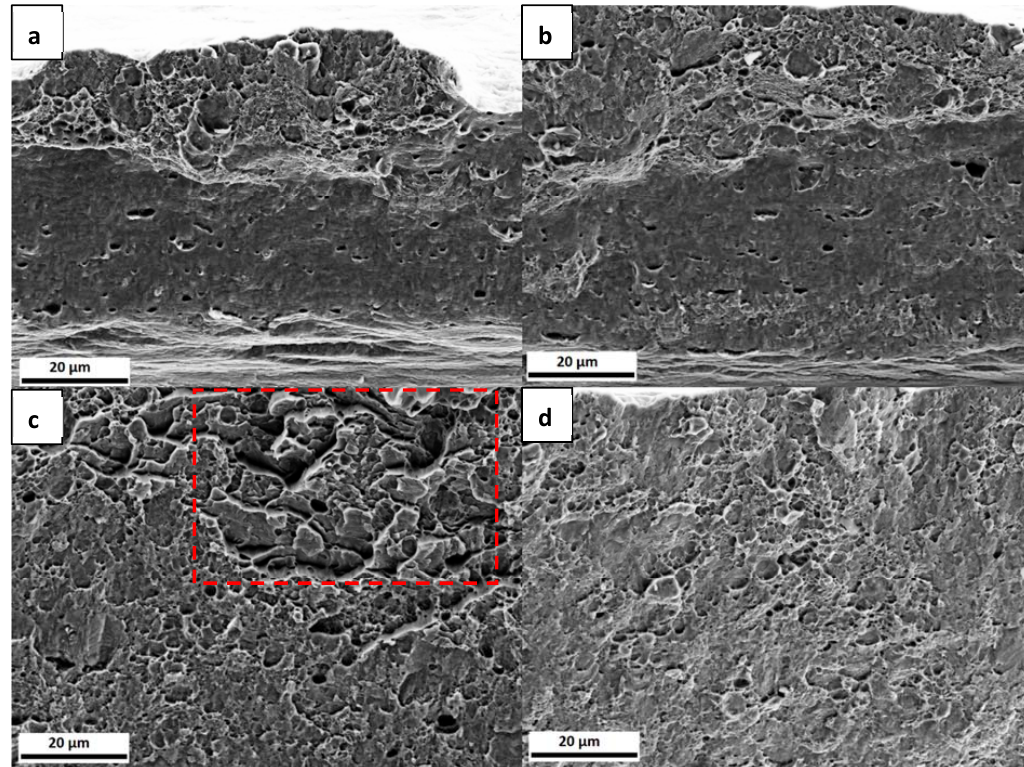
Figure 11. Fracture surfaces of the CP steel specimens tested with ( a ) 5 W; ( b ) 6 W; ( c ) 8 W; and, ( d ) 11 W. The red box in ( c ) indicates an area with shear fracture or specially oriented grains.